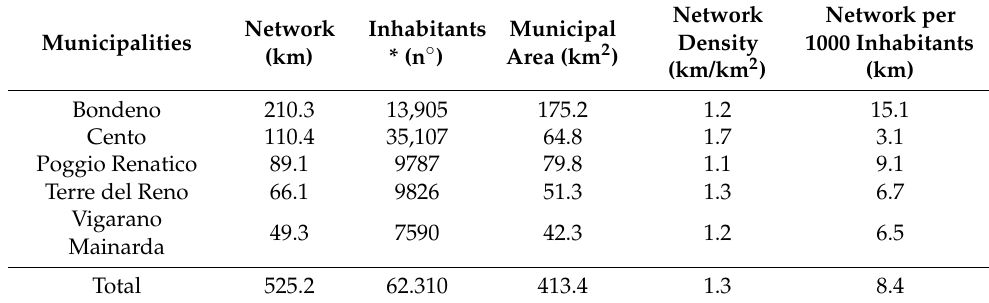
Network Density